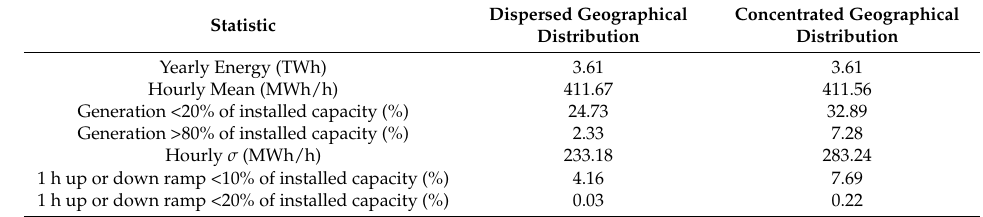
Figure 12. The PDFs estimated from the aggregated wind power generation with dispersed and concentrated geographical distribution. The dotted lines illustrate the corresponding hourly mean power generation (the dashed lines are overlapping). The presented simulation results are averages of 100 MC runs. Table 2. The numerical statistics estimated from the aggregated wind power generation with dispersed and concentrated geographical distribution. The <10%, <20%, and >80% rows show the percentage of hours in a simulation run when the aggregated generation or the one-hour ramp rates are within the respective limits. The presented statistics estimated from the simulation results are averages of the 100 MC runs.